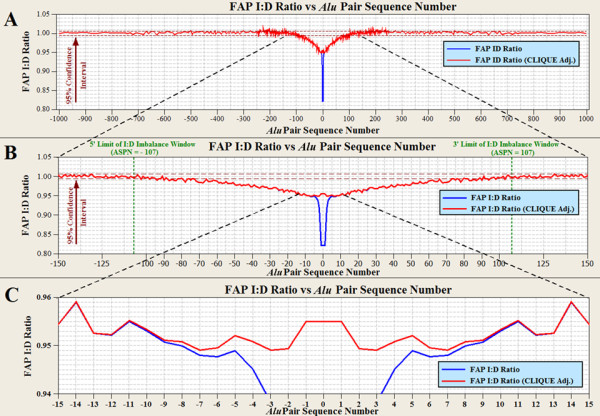
FAP I:D ratio versus Alu pair sequence number. The APSN, with (red) and without (blue) correction for CLIQUEs. (A) The I:D ratio of full length Alu pairs for APSNs of ± 1,000 Alu elements. Note that a bubble of depressed I:D ratio exists for those elements within about ± 100 Alu elements of the central Alu element. (B) A closer view of the I:D imbalance bubble. The 95% confidence for each value is estimated ± 0.6%. Therefore, the bubble of I:D imbalance extends for an approximately APSN = ± 85 around the central Alu. A more rigorous treatment of the data (see text) extends this I:D imbalance boundary to an APSN = ± 107. (C) Over 99% of the impact of CLIQUEs on the FAP I:D ratio dissipates after the APSN = 5. The largest CLIQUEs, while rare, contain up to 32 Alu elements. No CLIQUE impact exists on the FAP I:D ratio for an APSN > 31. APSN: Alu pair sequence number; CLIQUE: catenated LINE1 endonuclease induced queue of uninterrupted Alu, LINE1 and SVA elements; FAP: full-length Alu pair; I:D Ratio: ratio between inverted and direct Alu pairs.